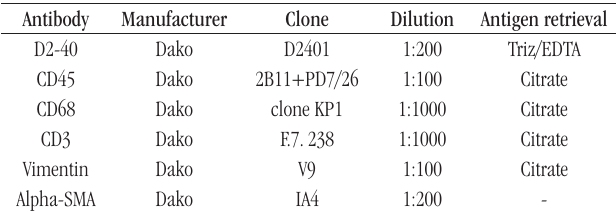
* All the antibodies are monoclonal.